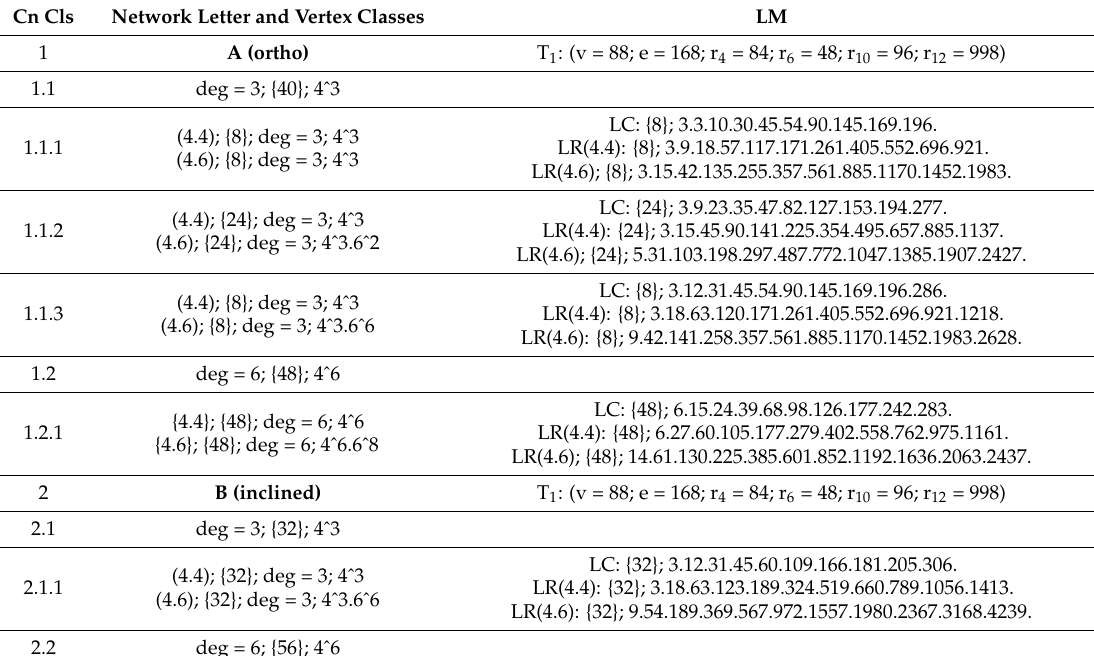
Table A1. Corner coalesced cubic pcu network: unit/tile; vertex connectivity classes; ring domain; population; degree; point symbol; LM sequence: connectivity (LC) and atom surrounding rings